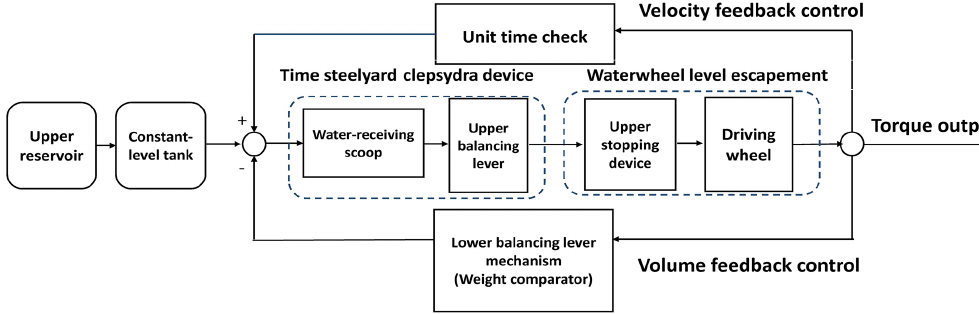
3. The astronomical device is composed of a celestial globe, Sun ring, Moon ring, and transmission